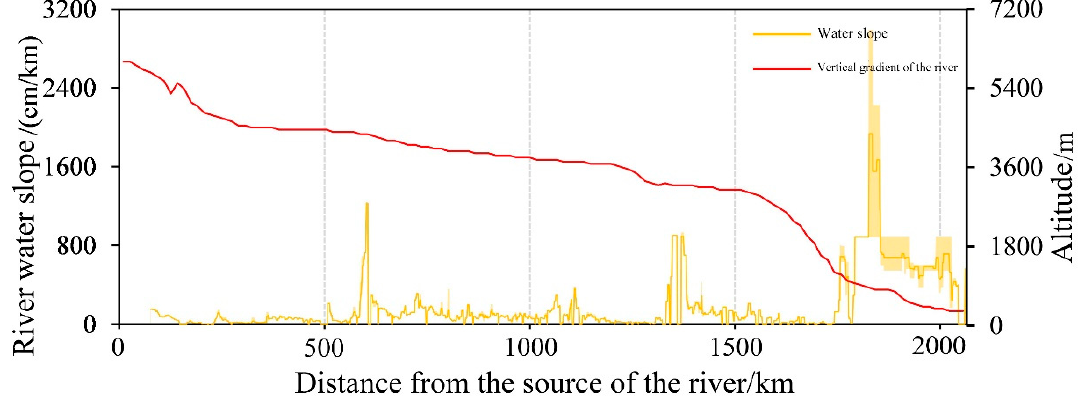
Figure 4. River water slope and longitudinal gradient of the Yarlung Zangbo River.